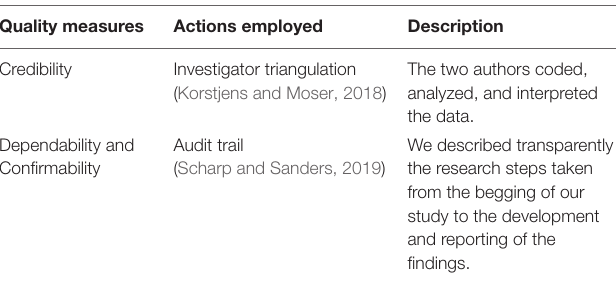
TABLE 1 | Quality measures that applied in the